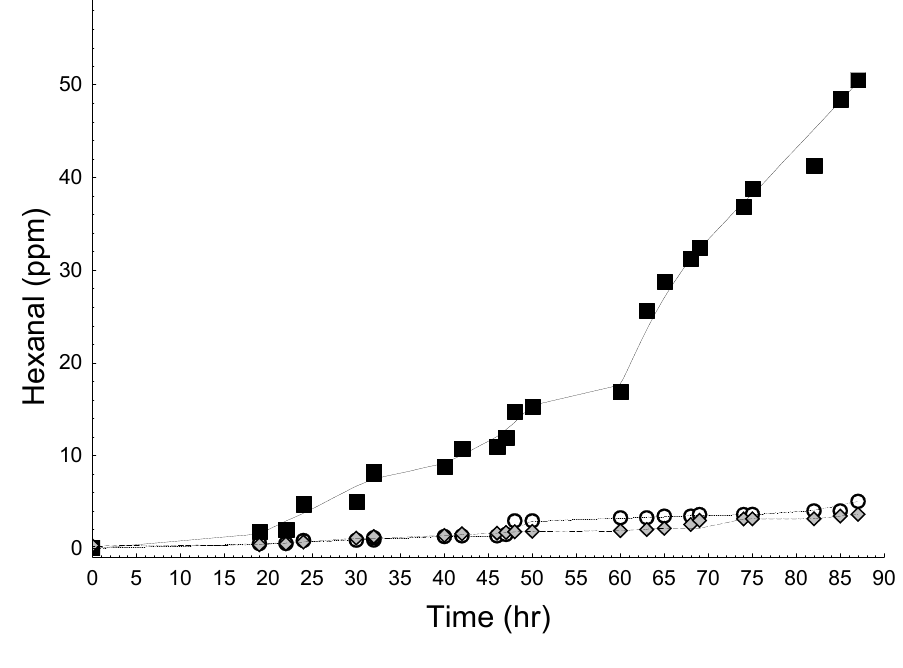
Figure 4. Production of hexanal in sunflower o/w emulsions during oxidation in the dark at 50 °C for control emulsion ( ■ ), emulsion containing whole cranberry extract (WCE) ( ○ ), and emulsion containing 100 ppm BHT ( ◊ ). Each point represents a duplicate